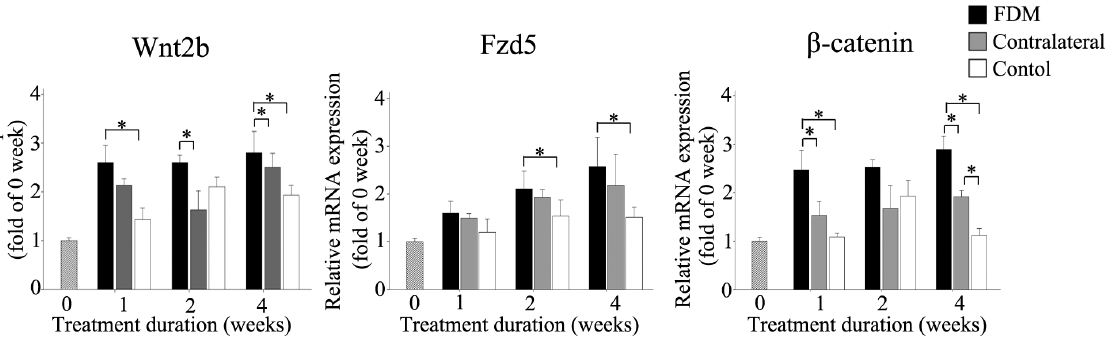
Figure 3. Expression of Wnt2b, FZD5 and b -catenin mRNA in mouse retinas as a function of treatment duration. Wnt2b mRNA was greater in the FDM than in the control group, after 1, 2 and 4 weeks of treatment; Fzd5 mRNA also was significantly greater in FDM than control, but only after 2 and 4 weeks of treatment, and b -catenin mRNA was greater in the FDM group than controls, but only after 1 and 4 weeks. Differences were also significant between FDM eyes and contralateral eyes at 1 and 4 weeks, and between contralateral and control eyes at 4 weeks. The expression level at week 0 was defined as 1, and the values were normalized to those of b -catenin mRNA levels. Retinas from both eyes of ten FDM mice and 6 control mice were used for each treatment duration. Data are presented as mean 6 SEM.(* P , 0.05).